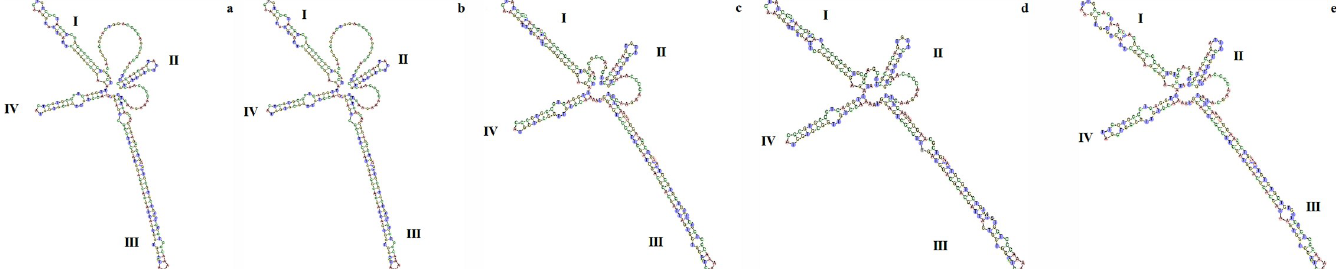
Fig 6. The predicted internal transcribed spacer 2 (ITS2) secondary structure of (a) clopyralid-resistant population (OR), (b) S . sessilis , (c), S . anthemifolia , (d) S . mutisii and (e) S . stolonifera . The four helices are labelled I–IV. The secondary structures were predicted and assessed using the ITS2 database web server (http://its2.bioapps.